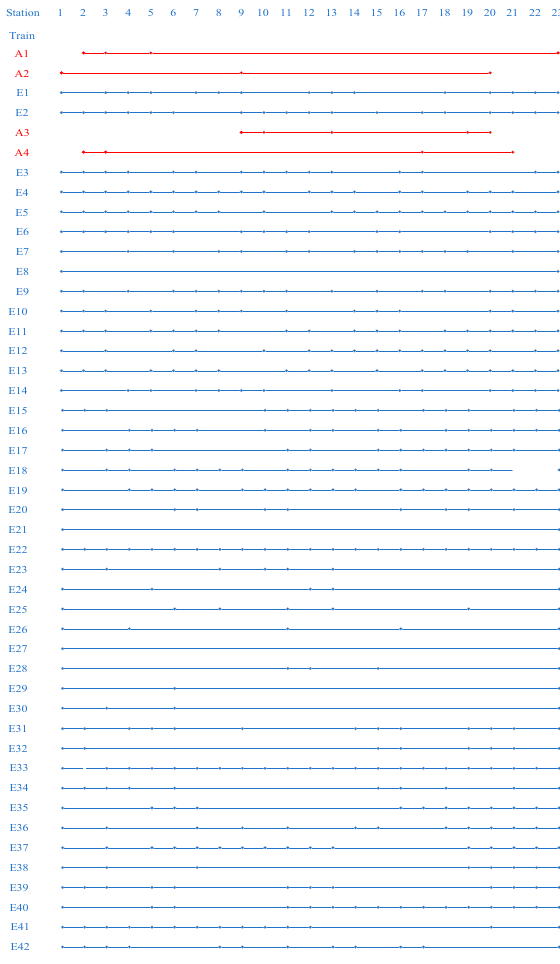
Figure 11. Stop plans for existing trains and additional trains on Beijing–Shanghai railway corridor.